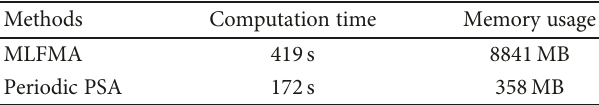
Table 3: Computation time and memory usage of MLFMA and periodic PSA for radiation of 10 × 10 antenna